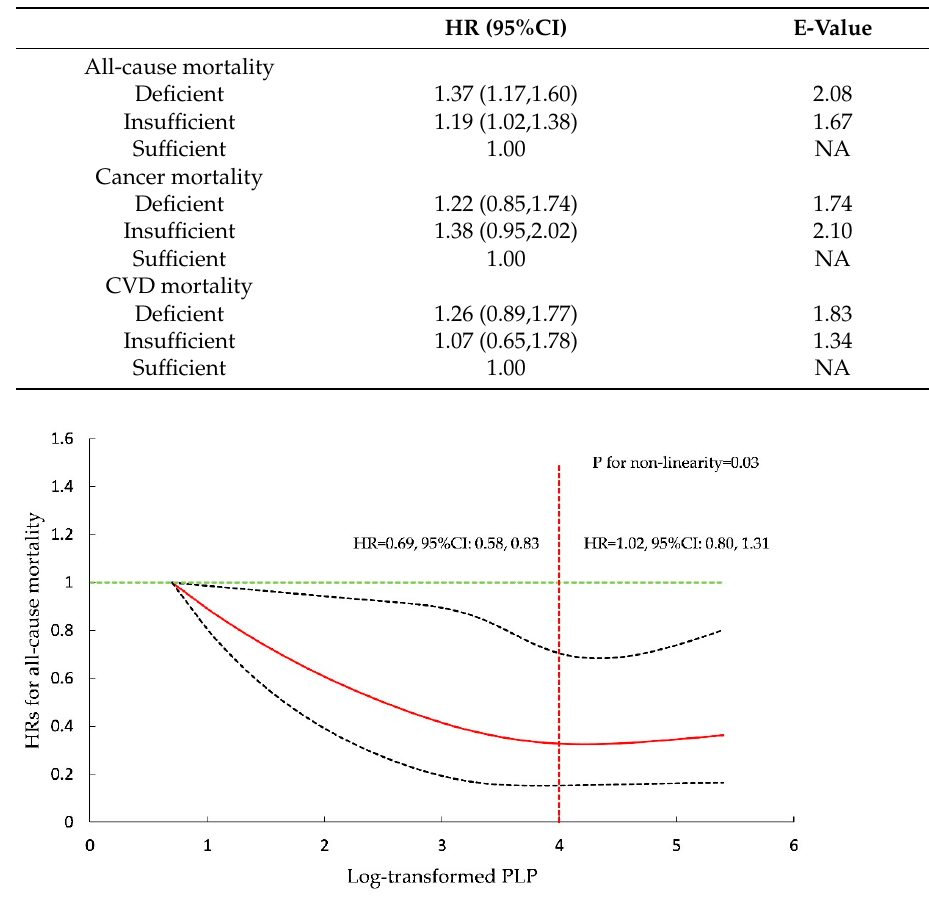
Figure 1. Association of pyridoxal 5 ′‐ phosphate (PLP) with all ‐ cause mortality in restricted cubic regression with four knots (5th, 35th, 65th, 95th) in NHANES participants from 2005 to 2010. In sensitivity analyses, the majority of the results were consistent with our primary results. When excluding deaths within 2 years of follow ‐ up, an association of deficient and insufficient vitamin B6 with all ‐ cause mortality was observed but was not statistically significant (Table S4). After further adjustment for eGFR, consistent results were obtained (Table S5). Furthermore, when serum vitamin B6 was classified as tertiles, the participants with lower serum vitamin B6 had lower all ‐ cause and cancer mortality (Table S6). 4. Discussion In the analysis of this nationally representative prospective cohort study of U.S. adults, we found that deficient and insufficient serum vitamin B6 were significantly asso ‐ ciated with a higher risk for all ‐ cause mortality. Participants deficient and insufficient in serum vitamin B6 had a higher risk for cancer mortality and CVD mortality, but these associations were not statistically significant. We also found a significant association of PLP as a continuous variable with all ‐ cause and CVD mortality. The prevalence of deficiency in serum vitamin B6 was 12.8% in our study, which was almost the same as that in a previous study (11%) [3]. This may be partly due to the fact that many common foods, such as various meats and vegetables, are rich in vitamin B6 and thus contribute to maintaining a sufficient vitamin B6 status [15]. To our knowledge, only a few studies investigated the association of serum vitamin B6 concentration with all ‐ cause and cause ‐ specific mortality [19–23]. A prospective cohort study examined the association of serum vitamin B6 concentration with all ‐ cause mortality and found that vitamin B6 concentration, whether as a continuous variable or categorized variable, was significantly associated with all ‐ cause mortality [19]. Meanwhile, Huang et.al. investi ‐ gated the effects of the vitamin B group on all ‐ cause mortality in elderly individuals in Taiwan and found that participants with sufficient vitamin B6 had a lower risk for all ‐ cause mortality, which is almost consistent with our results [21]. Moreover, a prospective case–cohort Study also found that renal cell carcinoma patients with high PLP had a sig ‐ nificantly lower risk for all ‐ cause mortality, which supports our results [22].